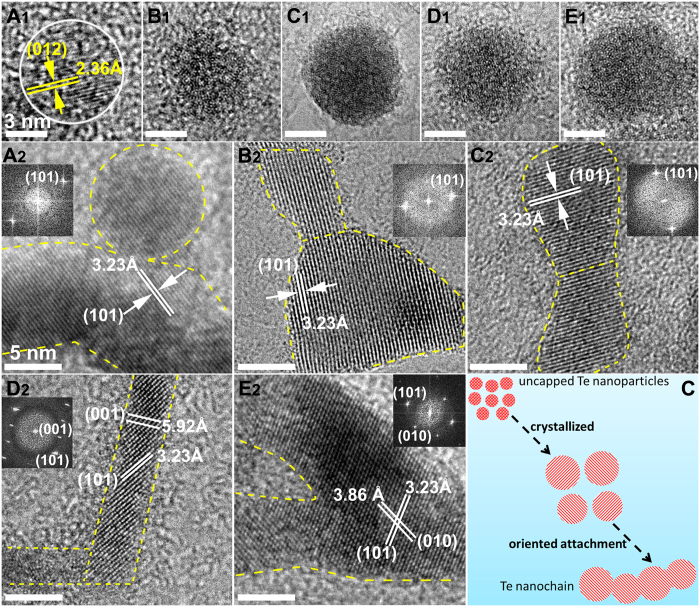
HRTEM images of an individual uncapped Te NP (A1–E1) and sectional Te nanochain (A2–E2) in H2O, CH3OH, CH3CH2OH, CH3COCH3, and CH2Cl2. Scale bar: 3 nm for A1–E1; 5 nm for A2–E2. Formation of Te nanochains dominated by the typical oriented attachment (OA) growth mechanism (F).